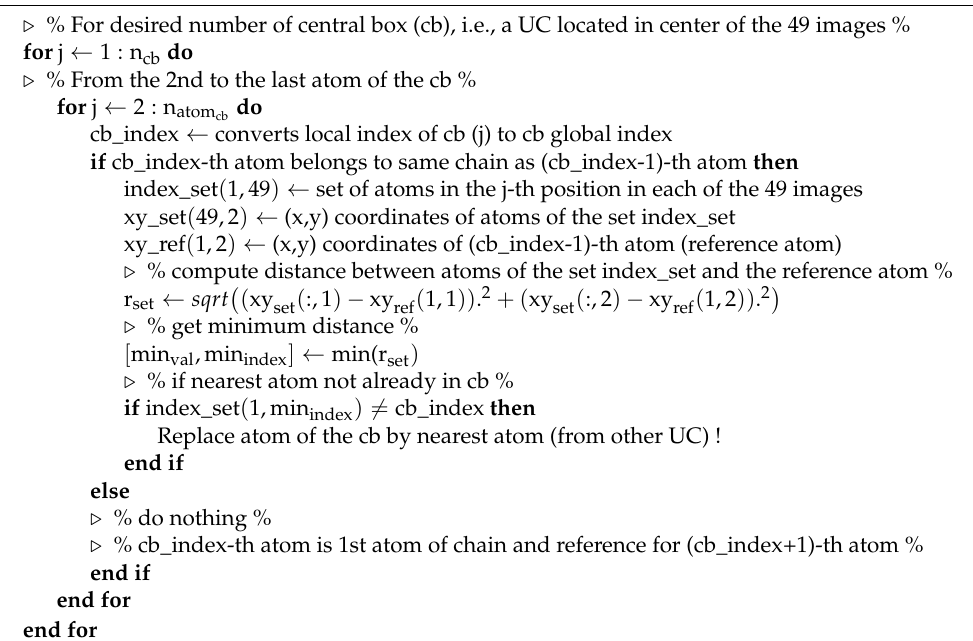
Algorithm A1 Extracting CLG NanoFiber from super cell of 49 CLG Fibril